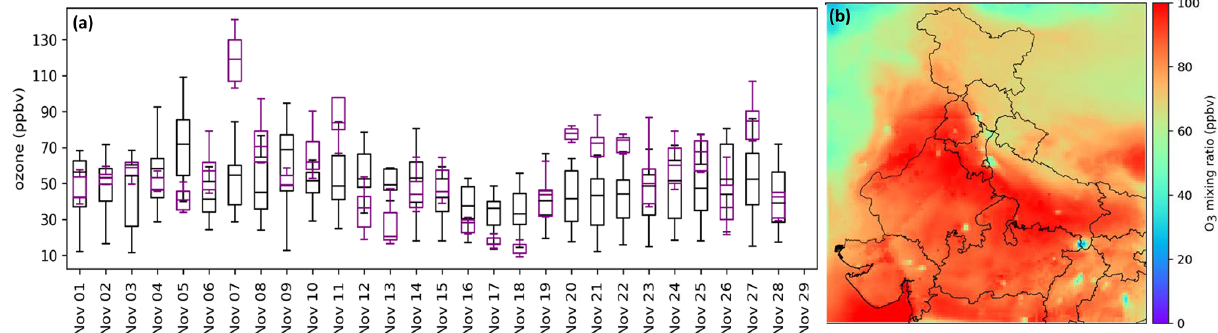
Figure 13. Daytime (08:00–18:00LT) ozone modeling performance in the base scenario. (a) Box-and-whisker plots of observed (black) and modeled (purple) concentrations averaged over all CPCB stations in Delhi. (b) November 2017 daytime-averaged